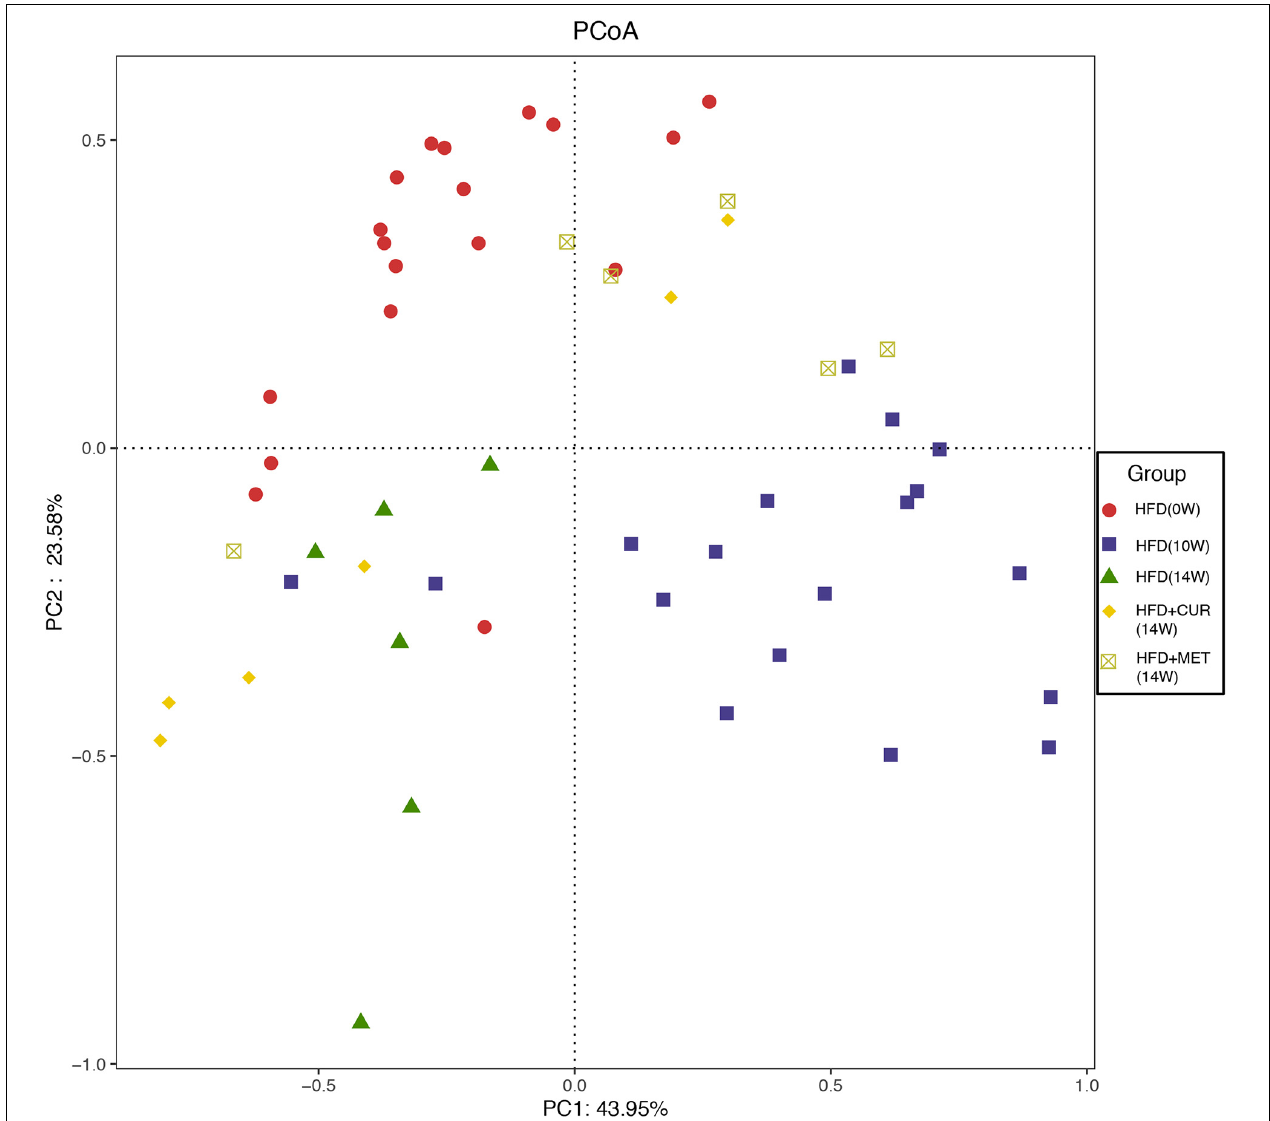
FIGURE 8 | PCoA score plot based on unweighted Unifrac